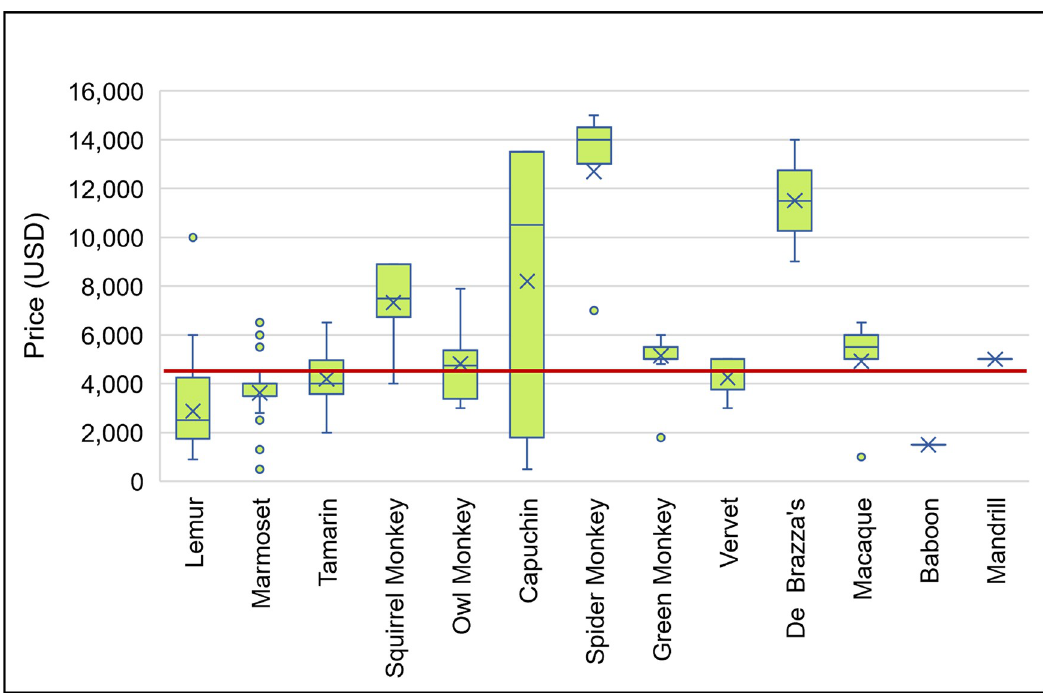
Fig 2. Price of primates for sale in the United States. Red line represents sample average ($4,618.14).